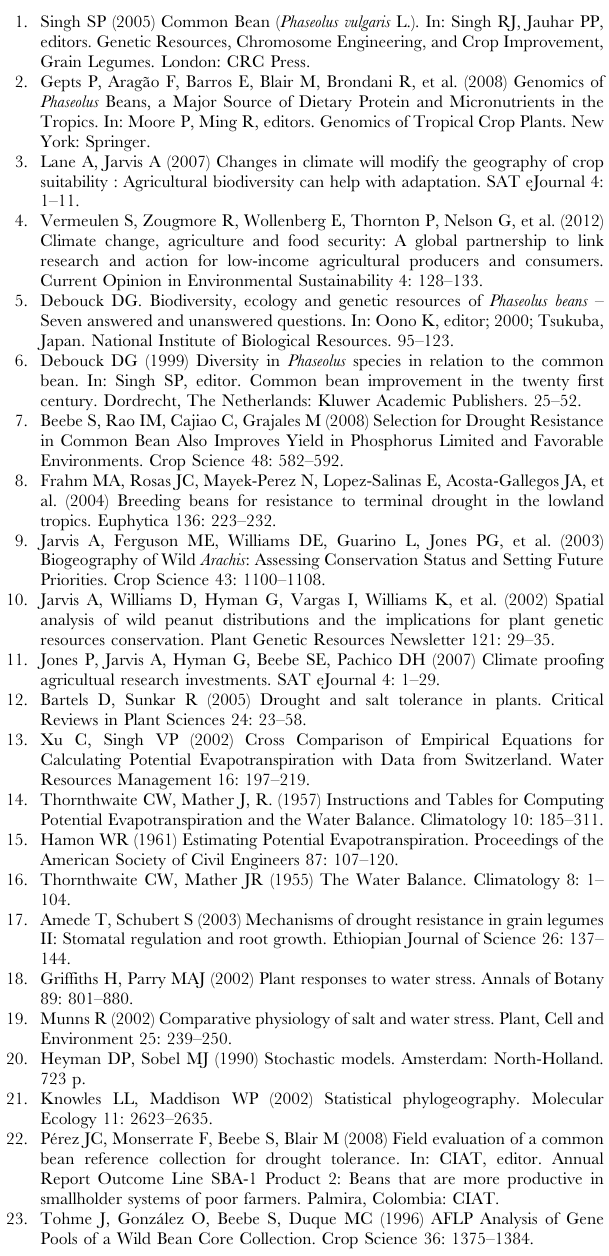
table 1). Accession names contain: accessions number + popula- tion assignation (Mesoamerican (Mexican wilds): K1, Guatemala: K2, Colombia: K3, Peru and Ecuador: K4, Andean (wilds from Argentina, Bolivia and southern Peru): K5), as defined by Blair et al. [26] and Broughton et al. [27] + quintiles for habitat drought stress (annual mean Thornthwaite Drought Index (DI), maximum Thornthwaite DI, annual mean Hamon DI, maximum Hamon DI). Branch colors are based on population structure. Red lines indicate groups of accessions with overall high quintiles.